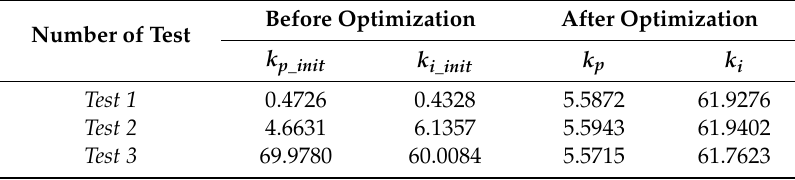
Table 1. The influence of the initial value selection on the final optimization results.